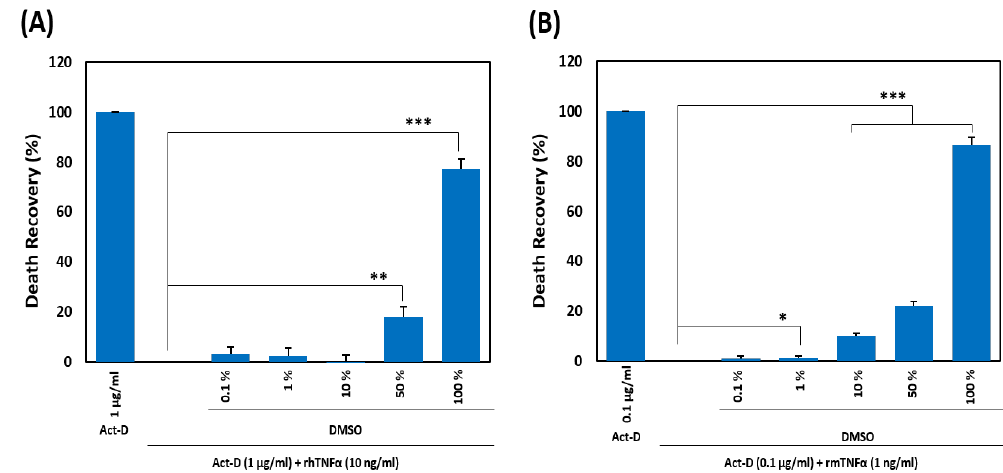
Figure 2. Inhibition of tumor necrosis factor-alpha (TNF-α)-induced cell death. ( A , B ) A comparison of the death recovery rate (%) between HDFs (10 4 /well) ( A ) and L929 cells (1.5 × 10 4 /well) ( B ) was carried out by treating them for 24 h with either TNF-α only or the indicated concentrations of DMSO preincubated for 1 h with rhTNF-α. The cell viability was measured by a colorimetric MTT assay. All experiments were independently conducted four times and means ± SEM of the independent experiments were subjected to a two-tailed paired Student’s t -test (* p < 0.05, ** p < 0.01, *** p < 0.001). Act-D = actinomycin D.